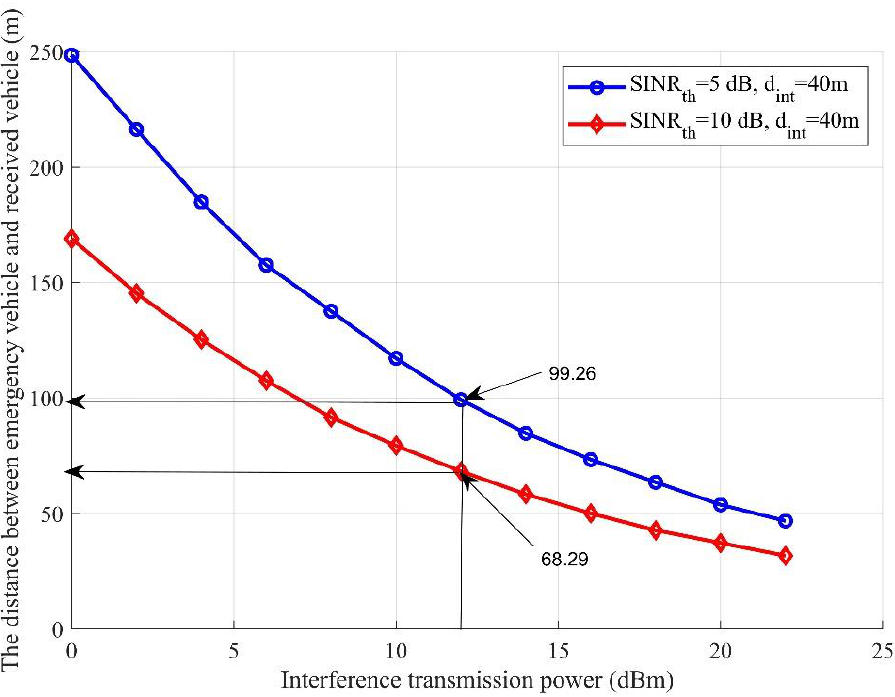
Figure 3. The distance between the emergency vehicle and the receiving vehicle versus interference transmission power.